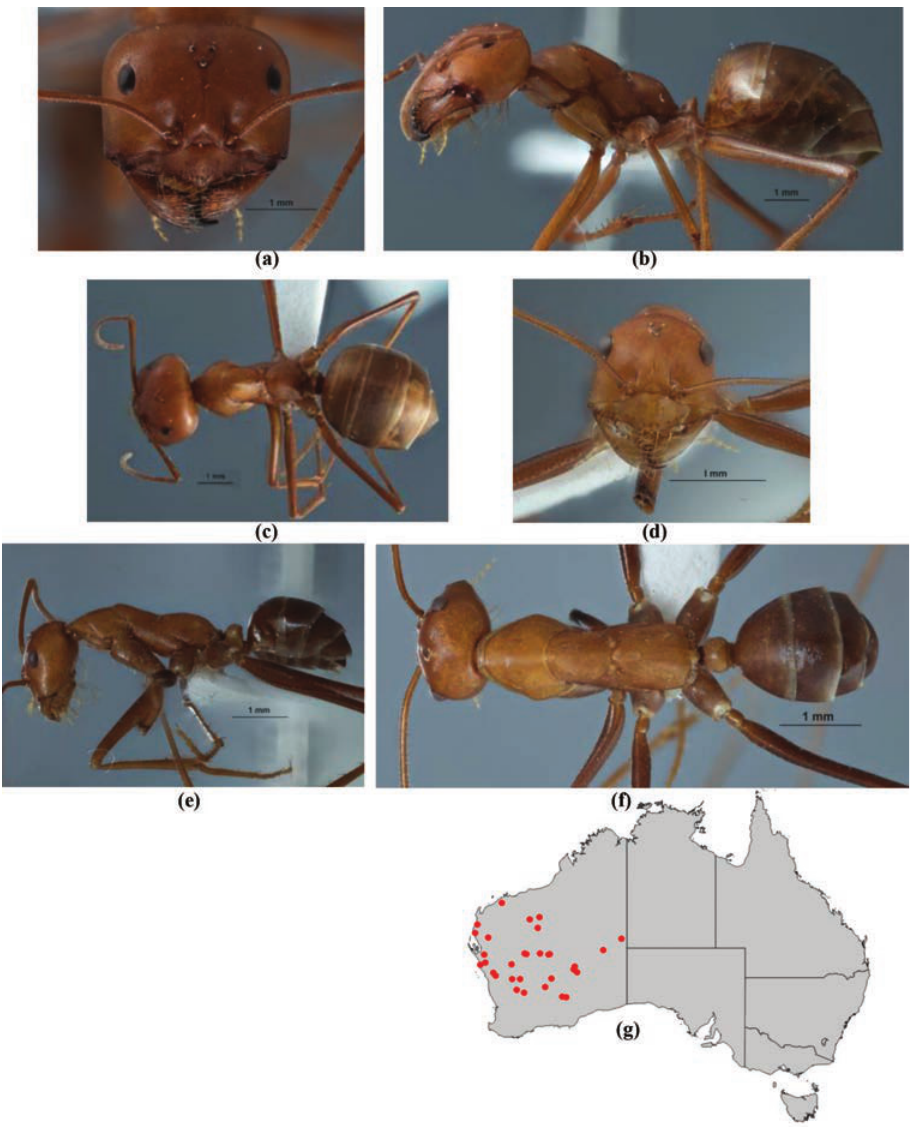
Figure 24. Melophorus gracilipes sp. n.: major worker paratype (ANIC32-032240–top ant) frons ( a ), profile ( b ) and dorsum ( c ); minor worker (ANIC32-032240–bottom ant) holotype frons ( d ), profile ( e ) and dorsum ( f ); distribution map for the species ( g